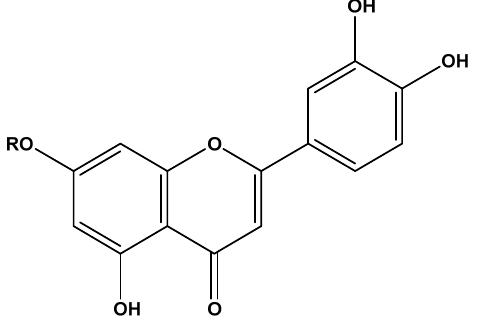
Figure 3. Chemical structure of 3 ′ ,4 ′ ,5,7 ‐ tetrahydroxyflavone or luteolin ( 1 ) and 3 ′ ,4 ′ ,5,7 ‐ tetrahydroxyflavone 7 ‐ O ‐ glucoside or luteoloside ( 2 ). ( 1 ) R = H; ( 2 ) R = Glucose.